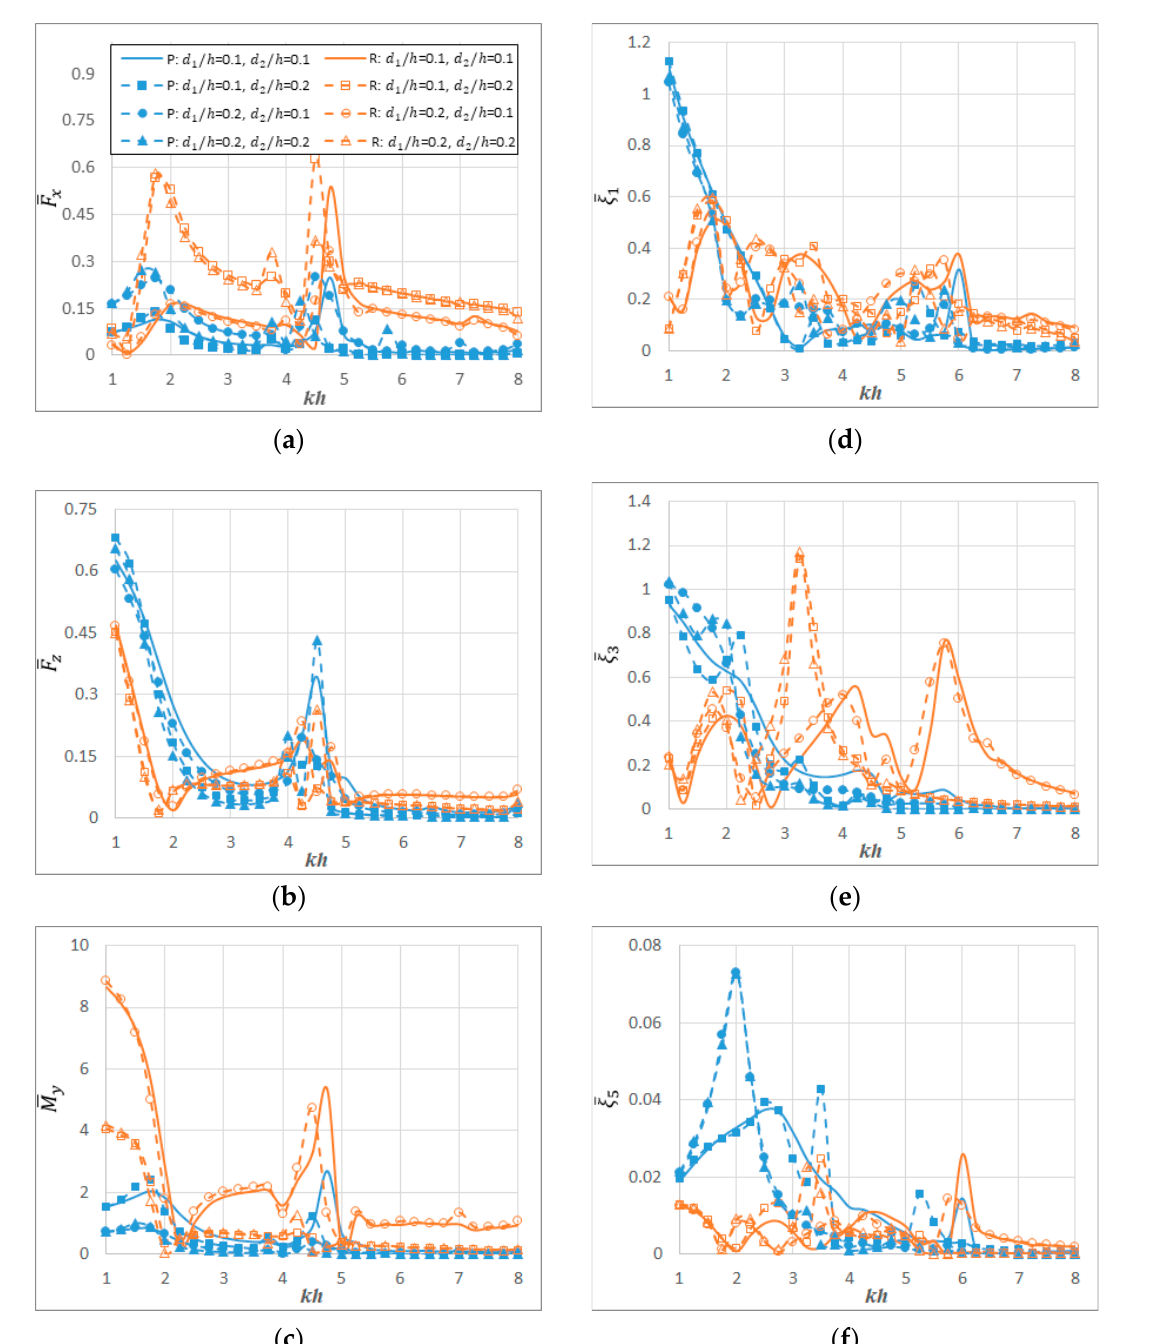
Figure 7. Normalised wave exciting forces and RAOs for floating hexagonal platforms and ring structures with various draft-to-water depth ratios: ( a ) surge force; ( b ) heave force; ( c ) pitch moment; ( d ) RAO for surge; ( e ) RAO for heave; ( f ) RAO for pitch.